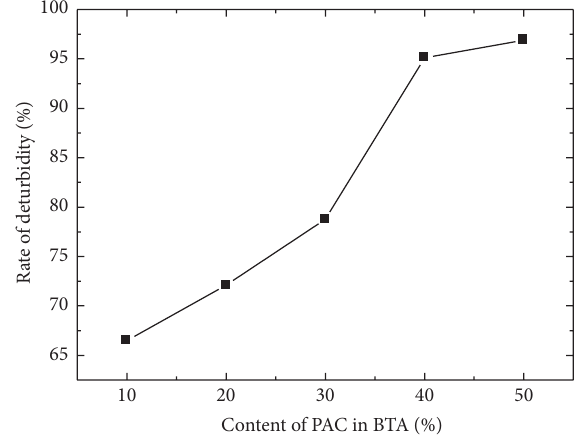
Figure 1: The effect of PAC in BAT on the rate of deturbidity.